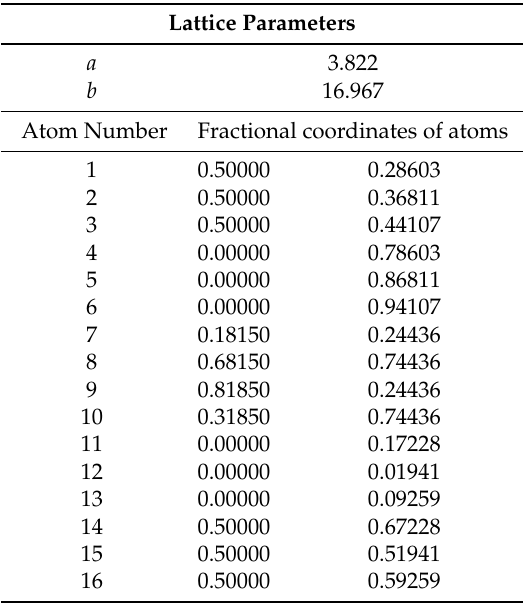
Table A1. Lattice parameters (Å) and fractional coordinates of atoms of Anisotropic-cyclicgraphene - rP16 - P1m1-conventional cell, Figure 1a.